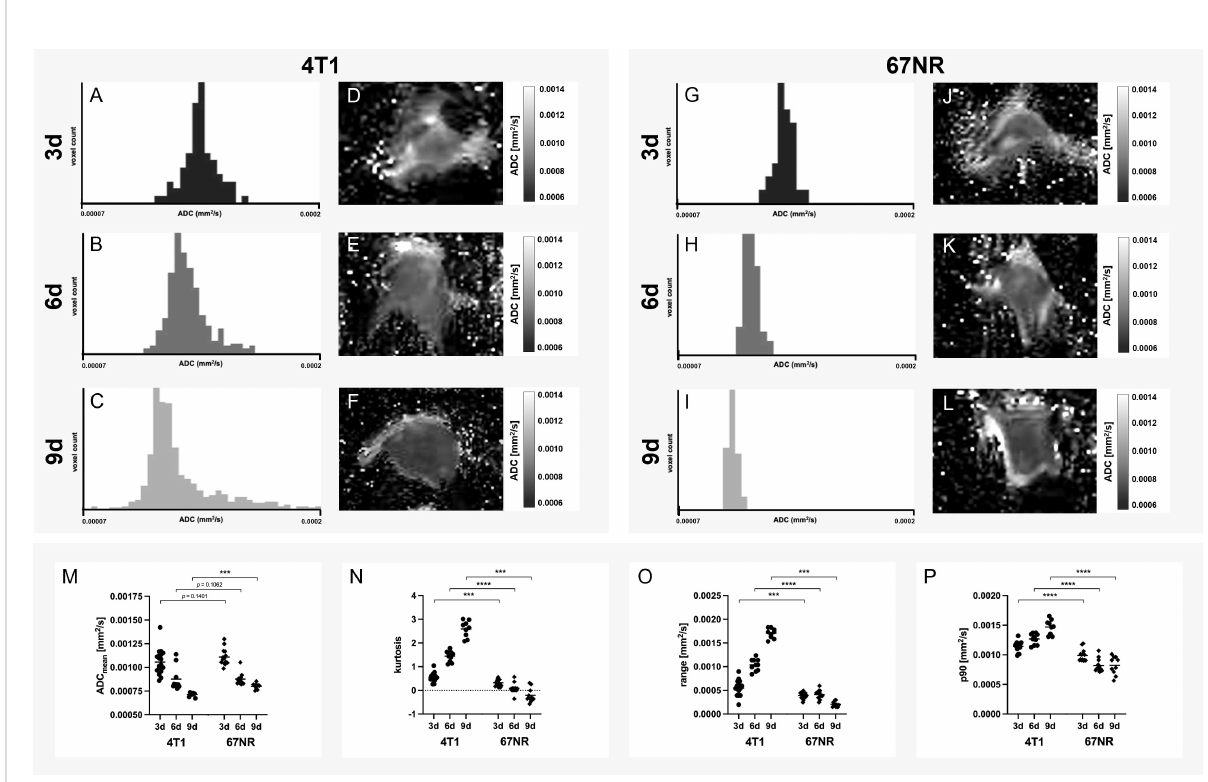
FIGURE 2 Histogram analysis of apparent diffusion coef fi cient. Exemplary histograms of 4T1 (A – C) and 67NR tumors (G – I) , as well as ADC maps (4T1 D – F , 67NR J – L ) on days three, six and nine and the corresponding analyses (M – P) . Mean ADC was lower in 4T1 tumors than 67NR tumors (M) , while both tumor models showed decreasing values over time. ADC histogram kurtosis (sharpness of the peak of the frequency-distribution curve, N), range (difference between maximum and minimum value, O ) and p90 (values above the 90 th percentile of all ADC values, P ) all increased in 4T1 tumors over time and were higher than in 67NR tumors, which exhibited less pronounced decreasing values in the assessed parameters over time. This corresponds with tumoral structural heterogeneity, which can also be seen in the exemplary histograms, with a great range of values in 4T1 tumors (A – C) and a small range in 67NR tumors (G – I) . Mean values of the ROI covering the tumor in single slice imaging are shown. *** p < 0.001, **** p <